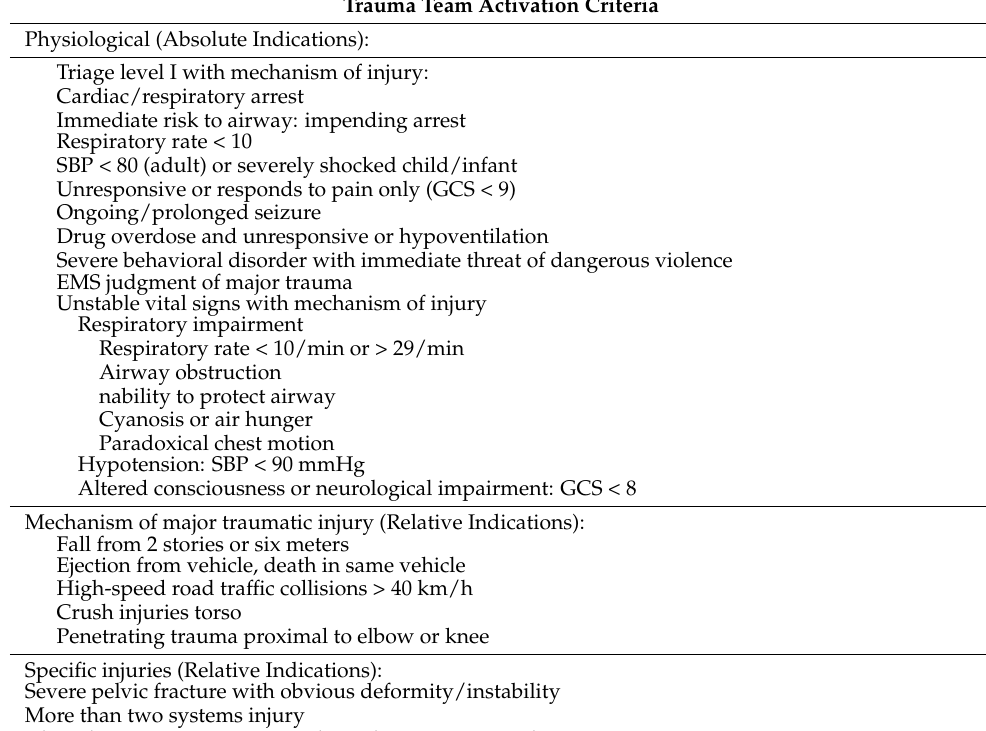
Table 1. Trauma team activation